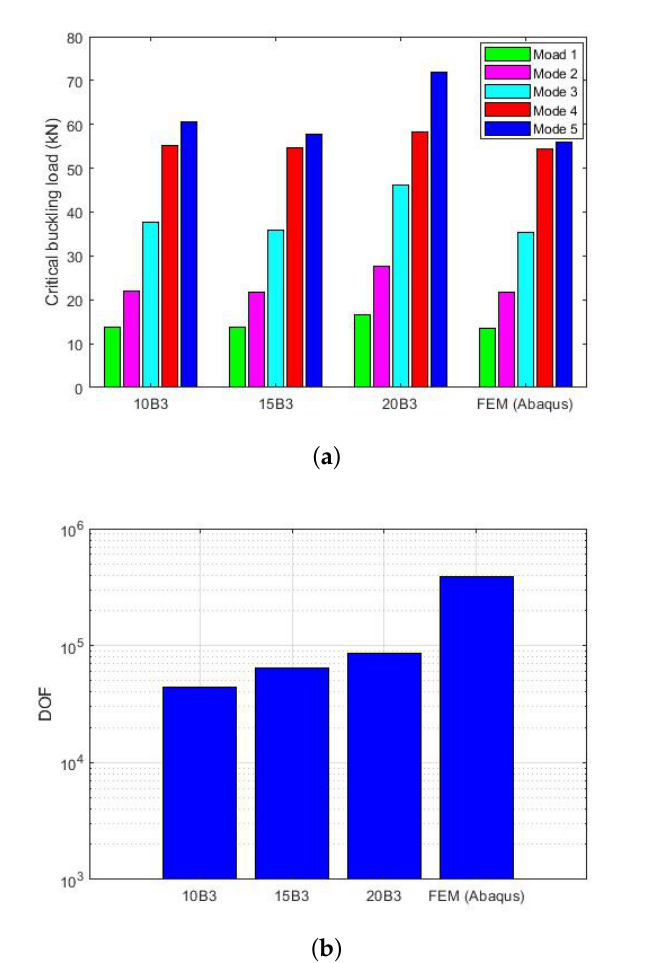
Figure 7. Refinement of a 1D CUF beam element with a 160 L 9 effect on the buckling load in VAT 1 in relation to the FEM and the number of degrees of freedom. ( a ) Beam refinement. ( b ) DOF based on beam